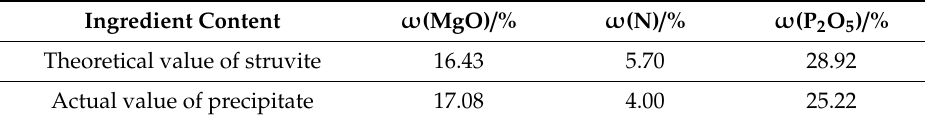
Table 5. Composition analysis of struvite precipitation.